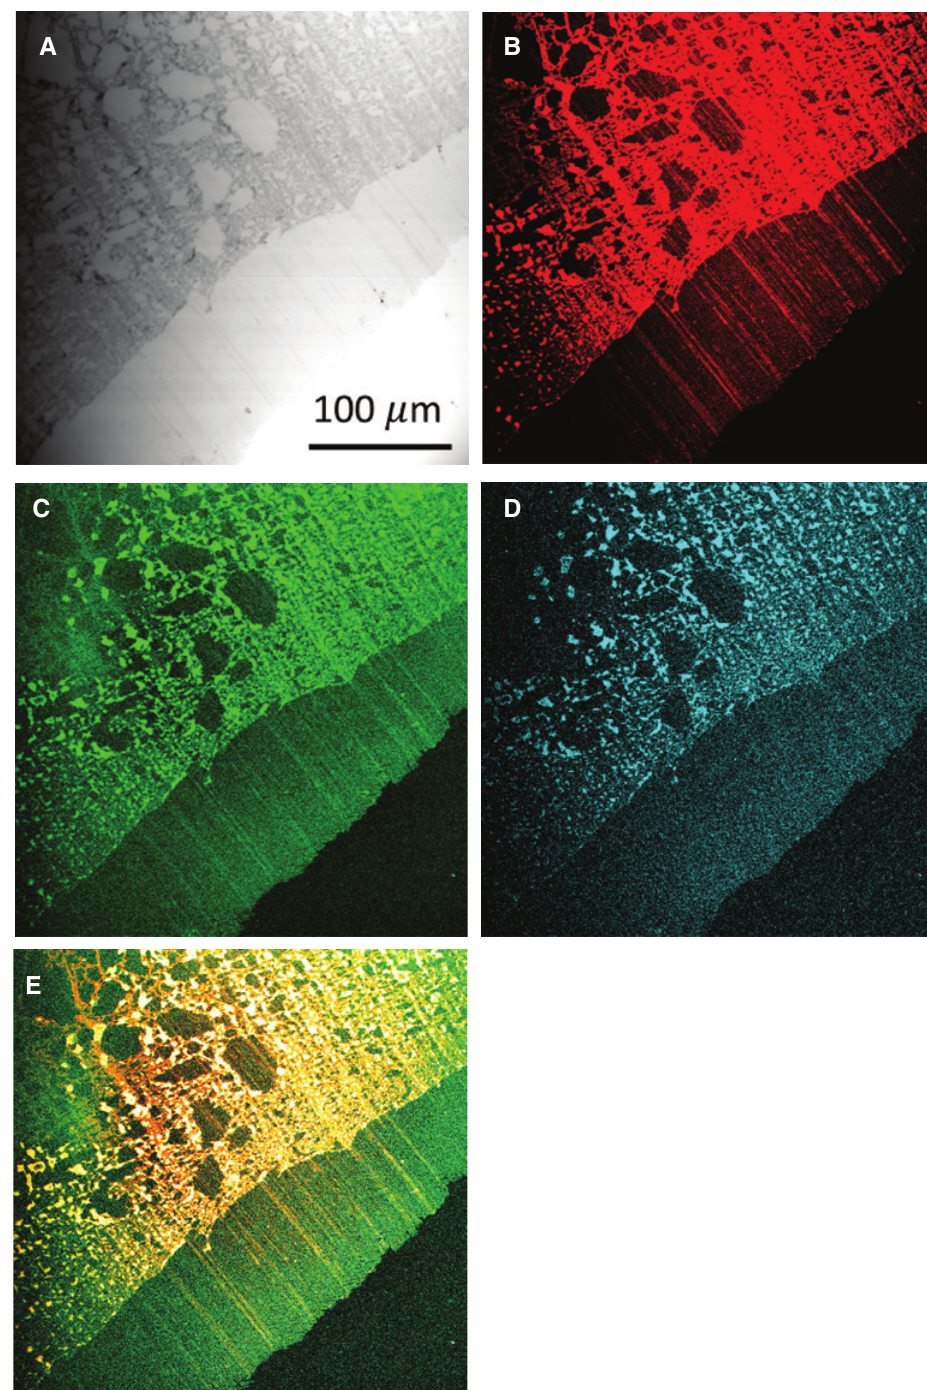
Figure 5: (A) Bright field image of graphene. (B) CARS image of graphene. (C) TPEF image of graphene. (D) SHG image of graphene. (E) The merged image of CARS + TPEF + SHG at Raman mode 1560 cm −1